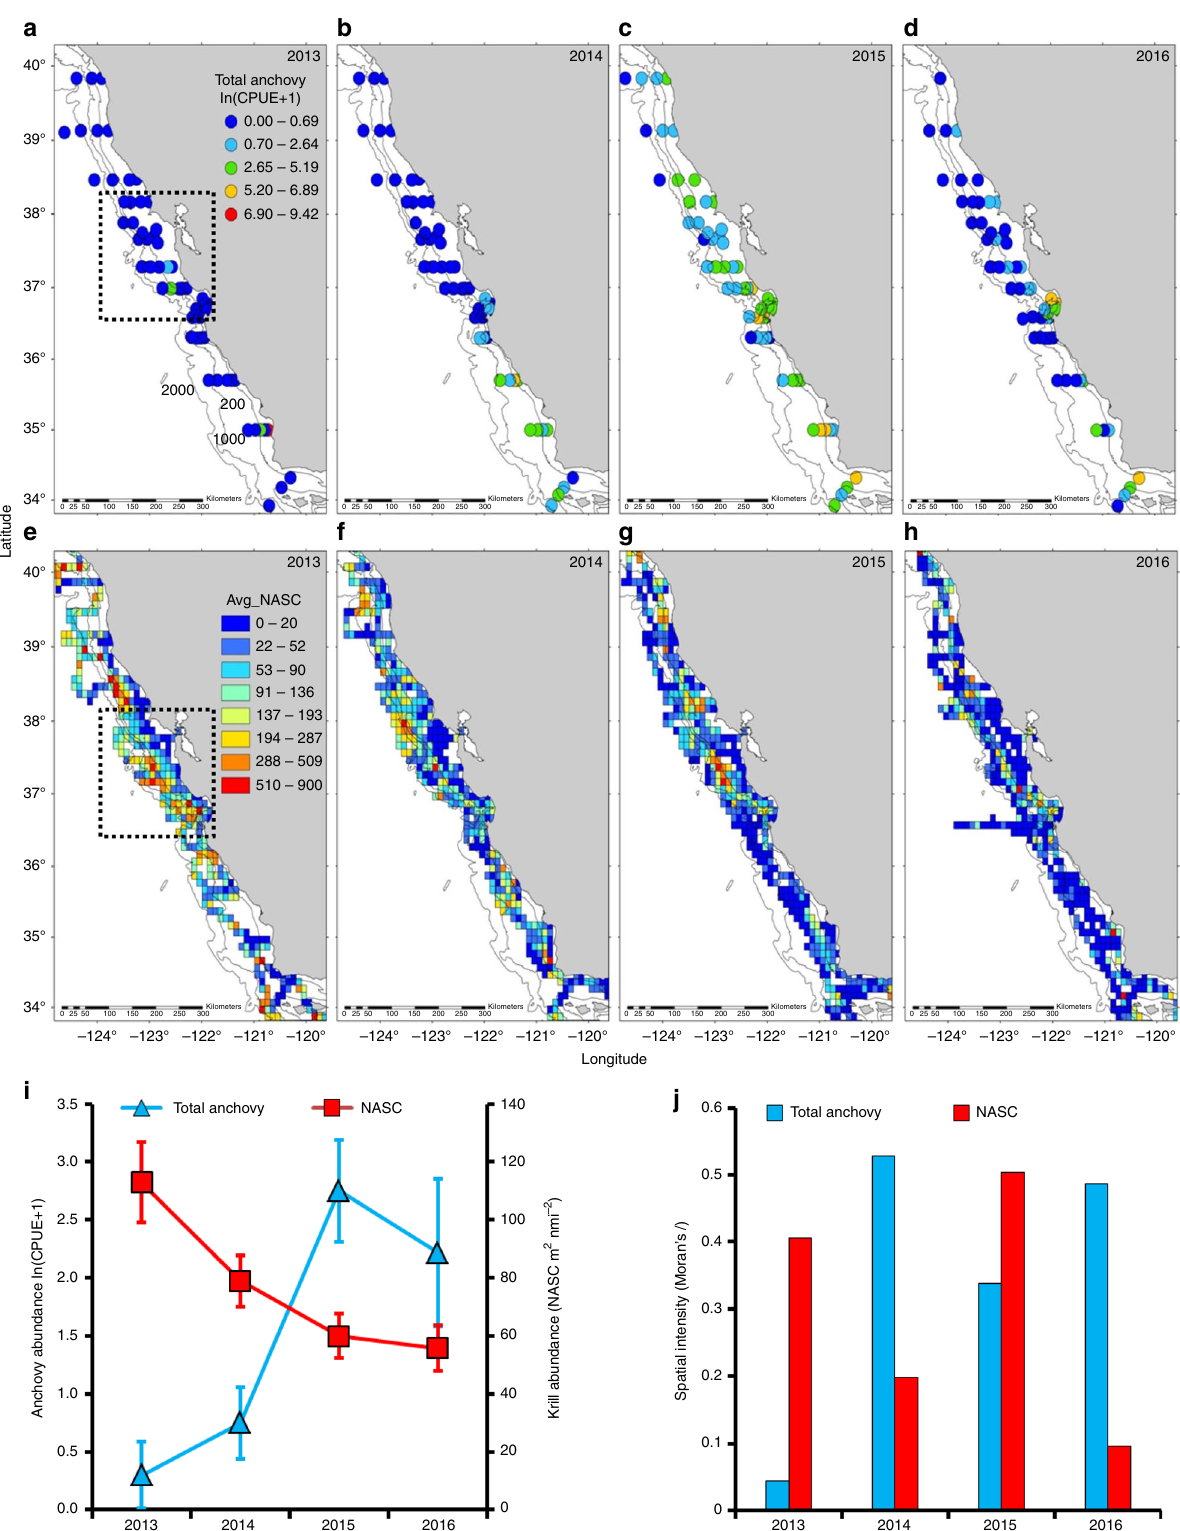
Fig. 3 Changes in the distribution of forage species distribution off California in the year preceding (2013) and during the marine heatwave (2014 – 2016). a – d Mid-water trawl catches (catch-per-unit-effort; CPUE) of total northern anchovy; e – h acoustically determined (NASC; m 2 nmi − 2 ) krill distribution and abundance, averaged onto a 25 km 2 grid. All survey data are derived from the Rock fi sh Recruitment and Ecosystem Assessment Survery (RREAS) during May – June. Dashed box indicates the long-term core sampling region of the RREAS; from Point Reyes 38° N to Monterey Bay 36.5° N. Map contours are the 200 m, 1000 m, and 2000 m isobaths (inshore to offshore; labeled in a ). i , j Changes in the mean (error bars denote 95% con fi dence intervals) relative abundance of total anchovy (blue) and krill (red), and corresponding changes in spatial intensity and clustering (indexed by Moran ’ s I ) for the mapped distributions per year. Source data are provided as a Source Data fi